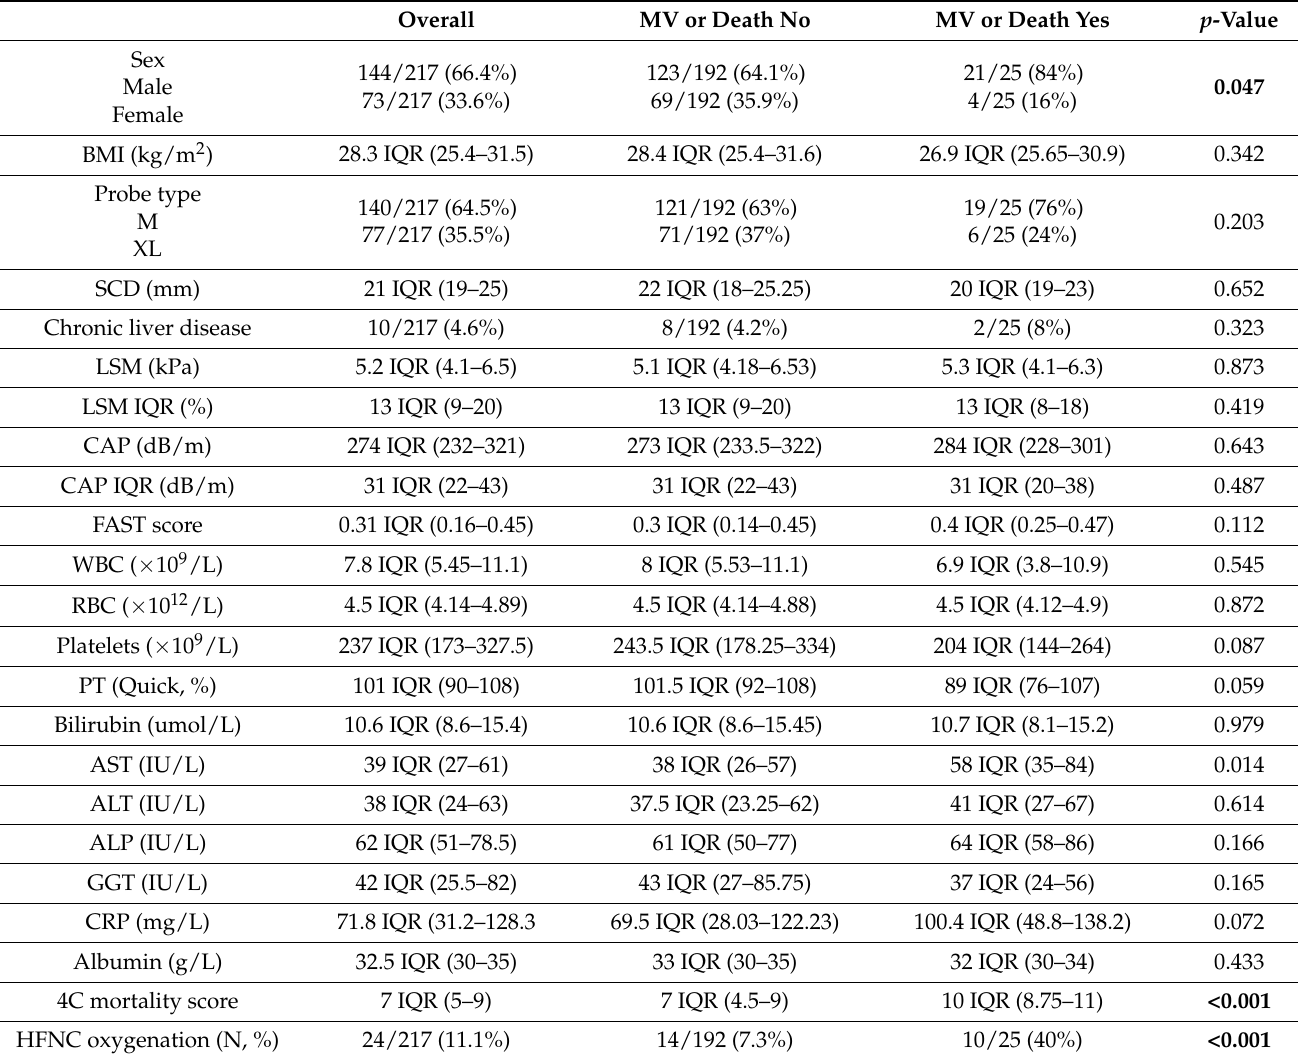
Table legend: BMI, body mass index; CAP, controlled attenuation parameter; FAST, FibroScan-AST score; LSM, liver stiffness measurement; IQR, interquartile range; SCD, skin-to-liver capsule distance; CRP, C-reactive protein; HFNC, high-flow nasal cannula; MV, mechanical ventilation; ALT, alanine transaminase; AST, aspartate aminotransferase; ALP, alkaline phosphatase; GGT, gamma glutamyl transferase; PT, prothrombin time; RBC, red blood cells; WBC, white blood